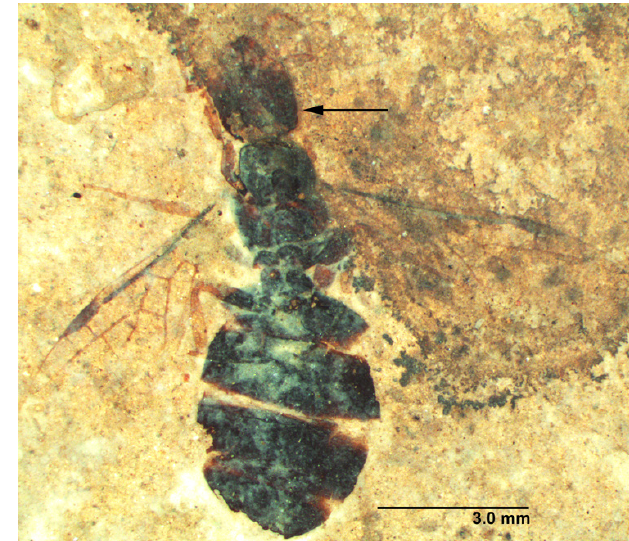
Fig 6 . Holotype queen, Protazteca eocenica (USNM# 609590). Arrow indicates rectangular head, characteristic of the